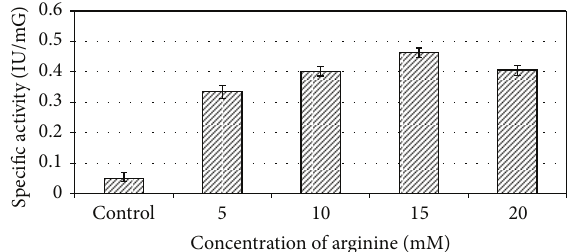
Figure 9: Effect of arginine (inducer) concentration on specific ADI activity of E. faecium sp. GR7. Results are expressed as the mean ± S.D ( 𝑛 = 3 ), 𝑃 -value < 0.05.